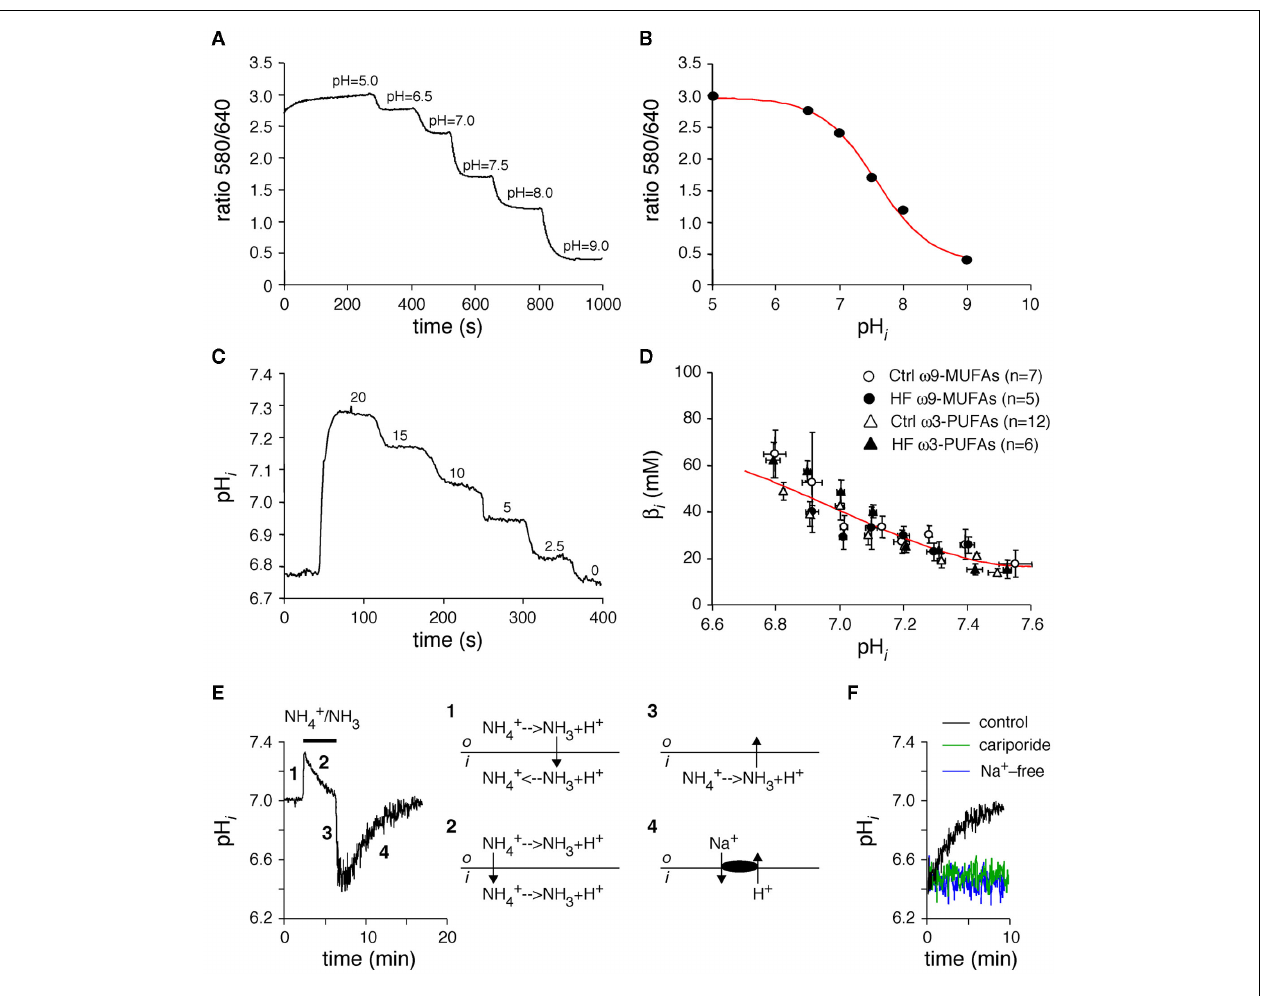
FIGURE 1 | (A,B) In vivo calibration curve of SNARF-AM.To determine calibration curve myocytes were loaded with SNARF-AM and superfused in presence op nigericin with several high K + solutions at various pH o values (A) .When the external and internal K + free concentrations are equal, pH i is the same as pH o .The calibration curve (B) was obtained by plotting the ratios (580/640) against the corresponding pH o .The red line represents a Henderson–Hasselbalch fit through these data, which revealed a maximum ratio of 2.97 and a minimum ratio of 0.36 and a p K a